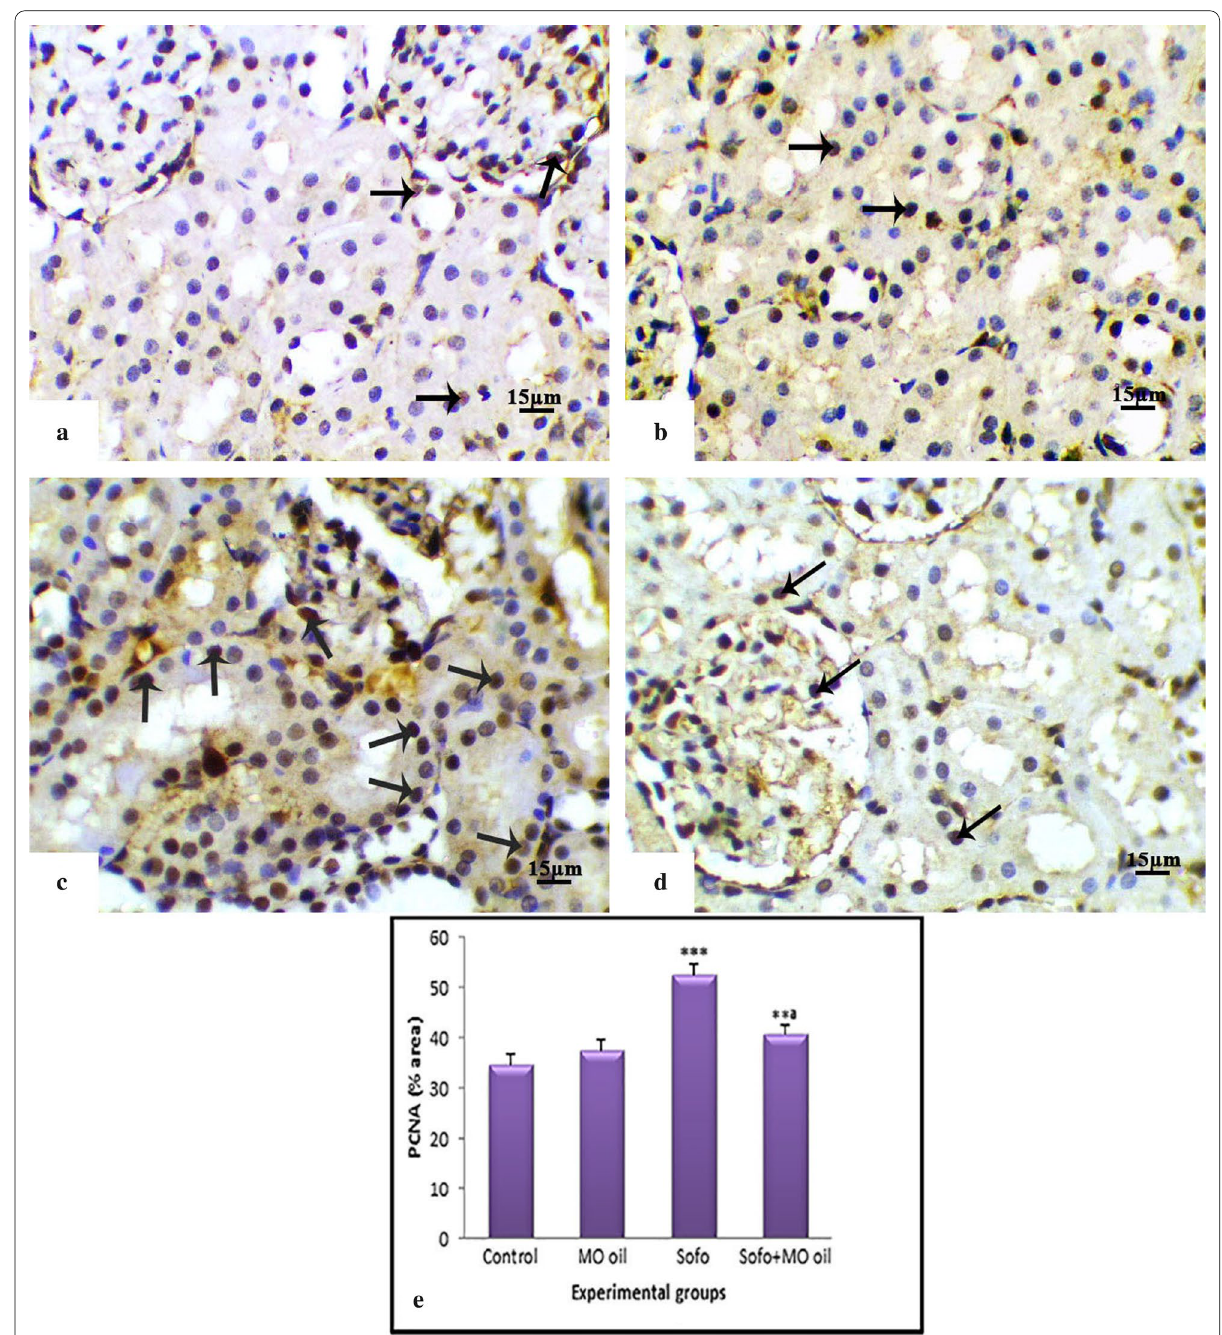
Fig. 4 Photomicrographs obtained from kidney sections of a control rat showing PCNA expression as brown color in few nuclei of glomerular and tubular cells (arrows), b MO oil-treated rat showing normal PCNA expression (arrows), c sofo-treated rat showing large number of nuclei with positive PCNA expression (arrows), d sofo- and MO oil-treated rat showing PCNA expression in some nuclei of glomerular and tubular cells (arrows), (PCNA immunostain, counterstained with hematoxylin, X 400). e The percentage area of PCNA expression in the different experimental groups. ( ⁎⁎ ) p < 0.001 and ( ⁎⁎⁎ ) p < 0.0001significant comparing with control group. (a) p < 0.0001 significant comparing with sofo